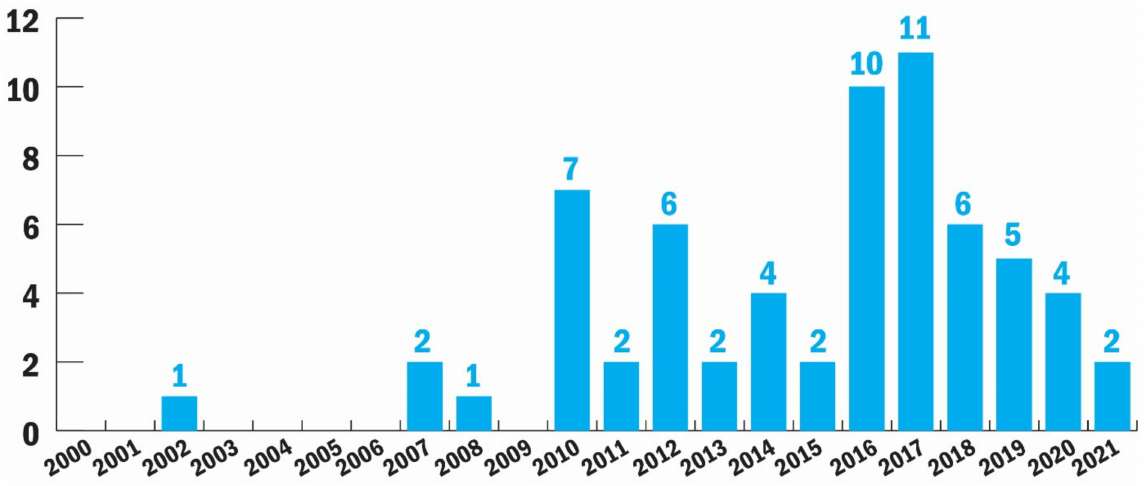
Figure 3. The number of articles according to the year of